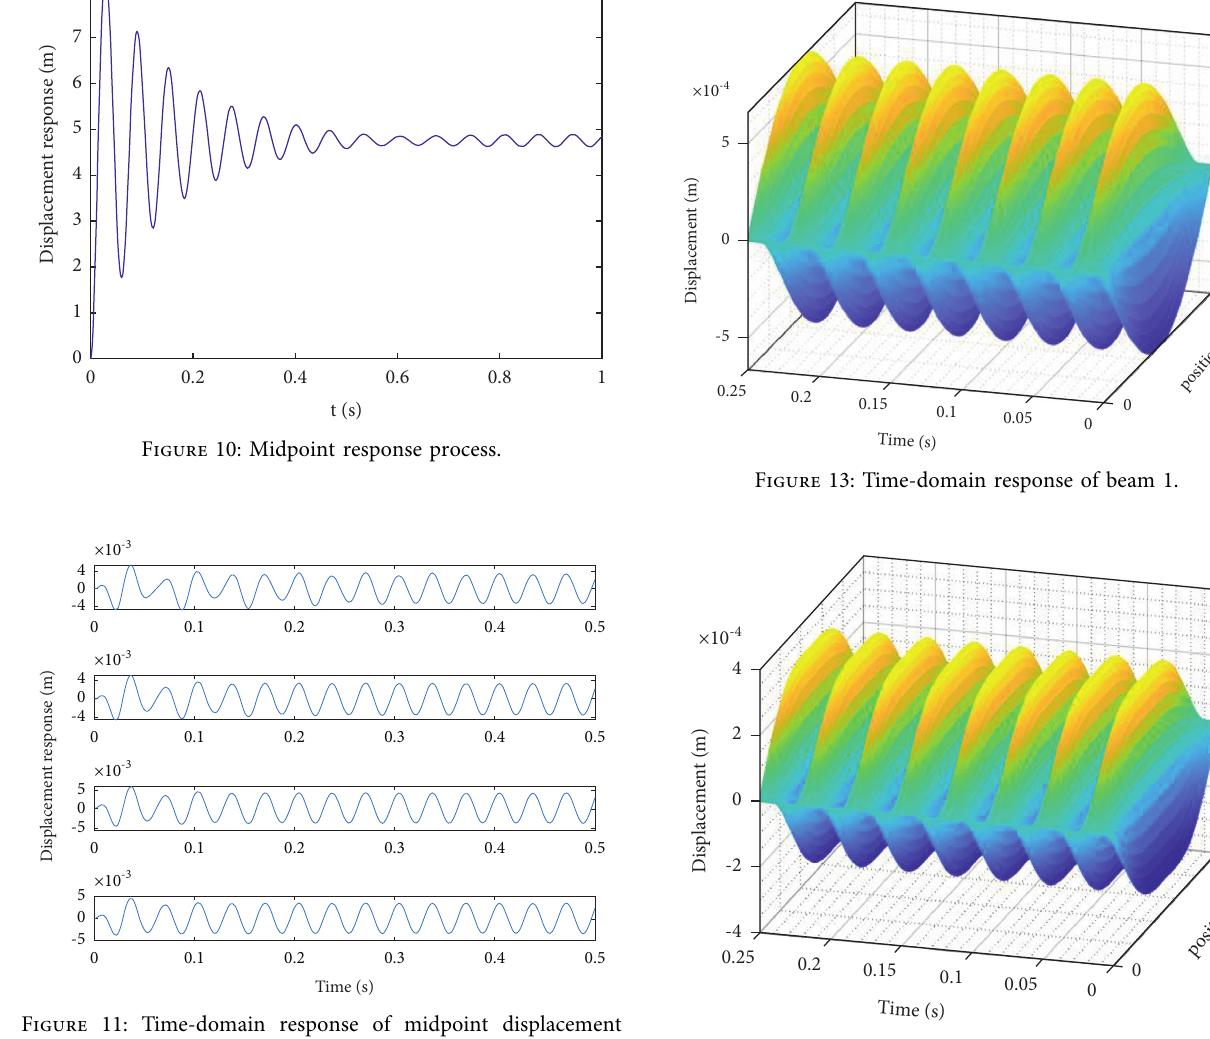
Figure 14: Time-domain response of beam 2.